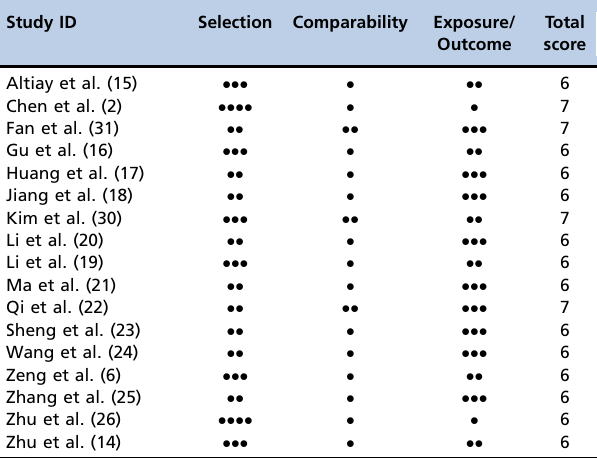
Table 2 - The Newcastle-Ottawa Scale (NOS) quality assessment of the eligible